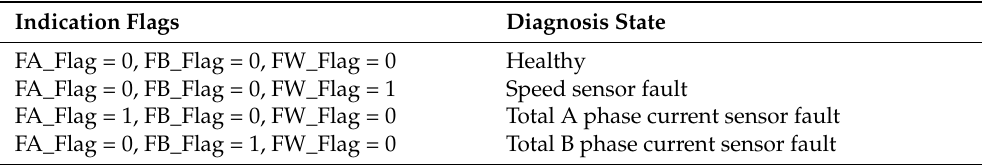
Table 1. Diagnosis function.